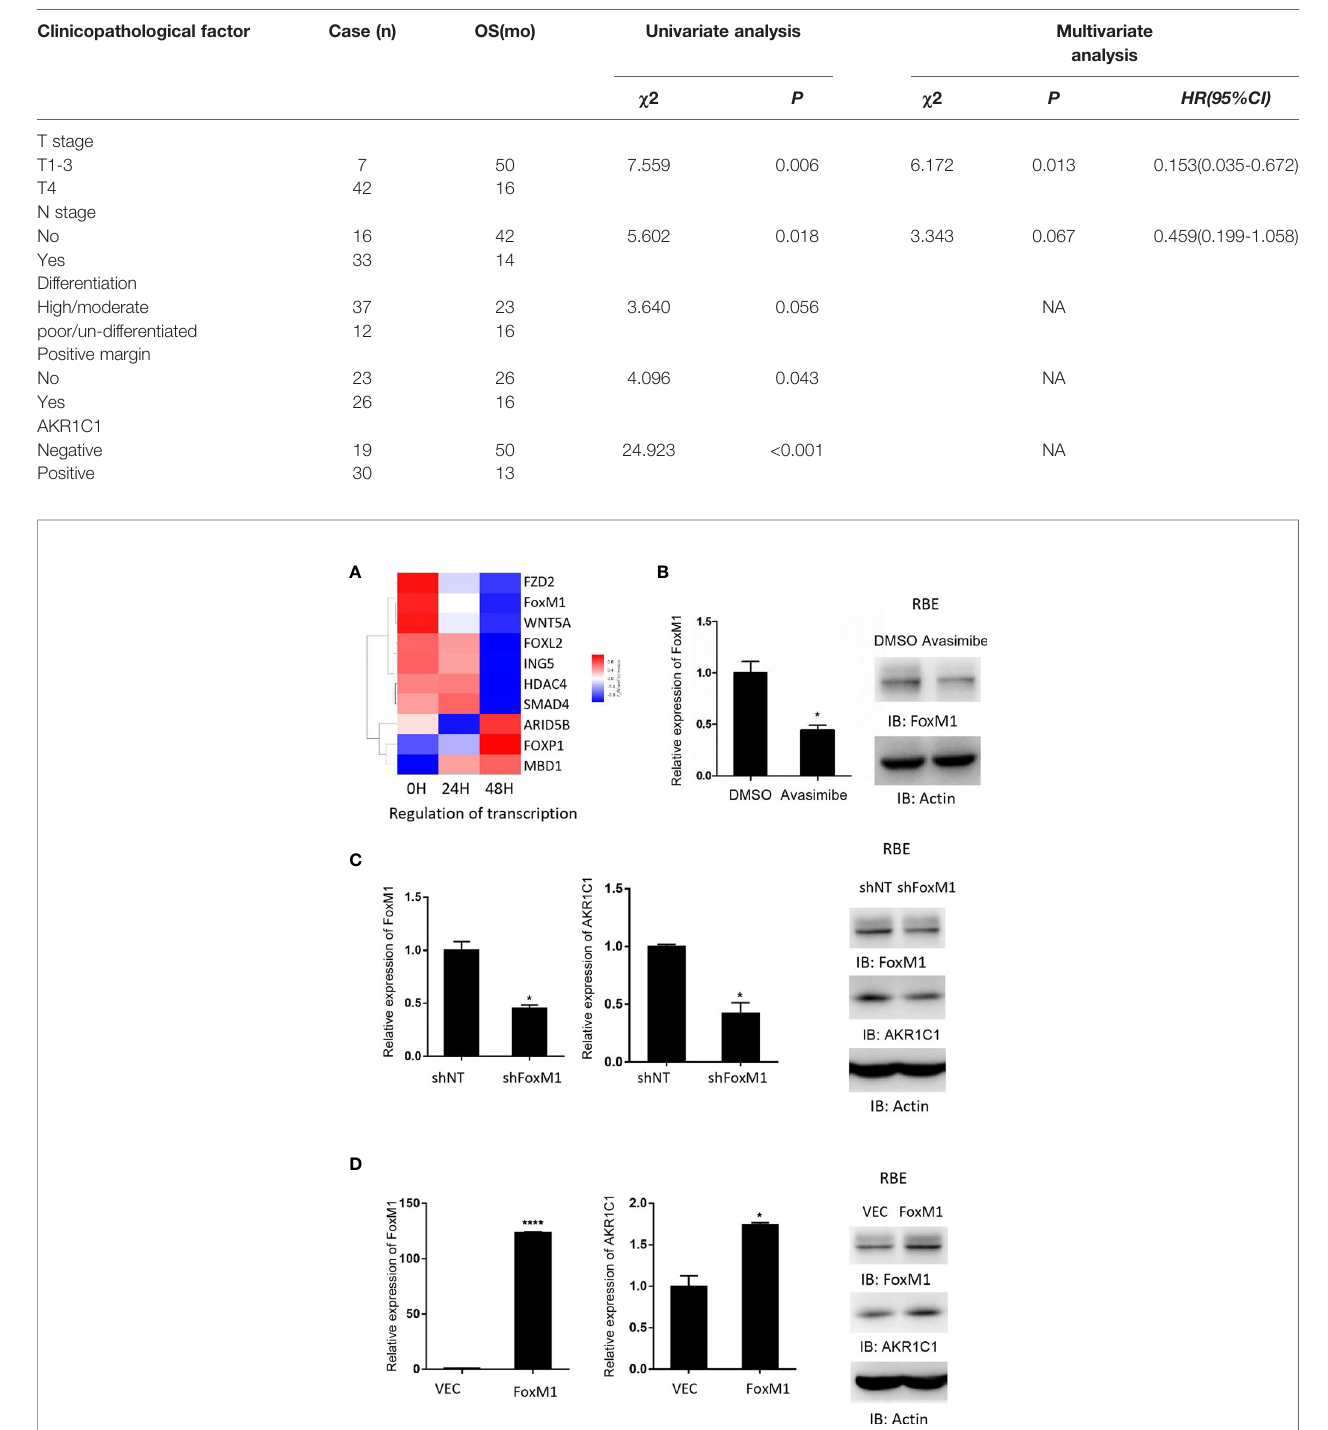
FIGURE 4 | AKR1C1 is regulated by FoxM1 in cholangiocarcinoma. (A) RBE cells were treated with avasimibe (20 µM) for 24 and 48 hours and subjected to cDNA array analysis. Cluster of changed genes in regulation of transcription was presented. (B) The level of FoxM1 mRNA and protein was detected by RT-PCR and western blotting in RBE cells when treated with avasimibe (20µM) for 48 hours. (C) RBE cells were transfected with FoxM1-shRNA for 48 hours and the levels of FoxM1 and AKR1C1 mRNA and proteins were detected by RT-PCR and western blotting. (D) RBE cells were transfected with FoxM1 plasmid for 48 hours and the levels of FoxM1 and AKR1C1 mRNA and proteins were detected by RT-PCR and western blotting. *P < 0.05, ****P <